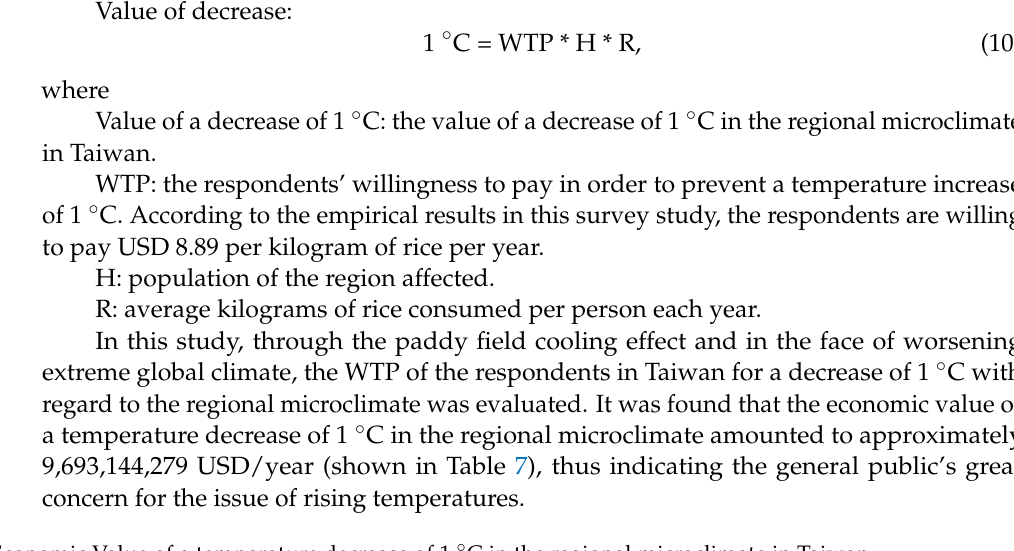
Table 7. The Economic Value of a temperature decrease of 1 ◦ C in the regional microclimate in Taiwan. Willingness to Pay (WTP)